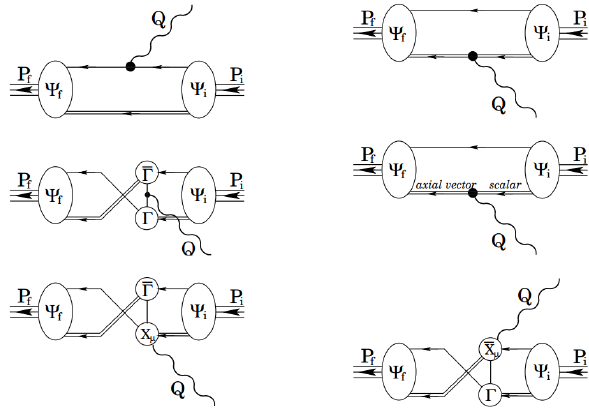
Figure 2. Vertex that ensures a conserved current for on-shell baryons that are described by the Faddeev amplitudes produced by the equation depicted in Fig.1: single line , dressed-quark propagator; undulating line , photon; Γ , diquark correlation am- plitude; and double line , diquark propagator. Diagram 1 is the top-left image; the top-right is Diagram 2; and so on, with Di- agram 6 being the bottom-right image. (Details are provided in Ref.[12], Appendix